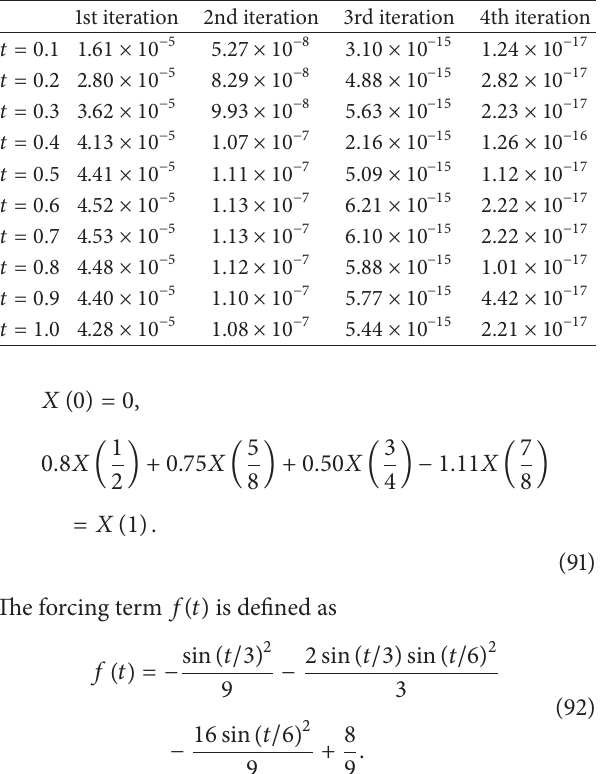
Table 4: Absolute difference of exact and approximate solution of Example 4 at different stages of the